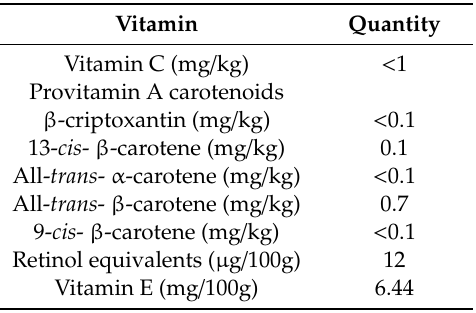
Table 3. Vitamin pattern of Intosso d’Abruzzo cv. table olives. From Lanza et al. [54].